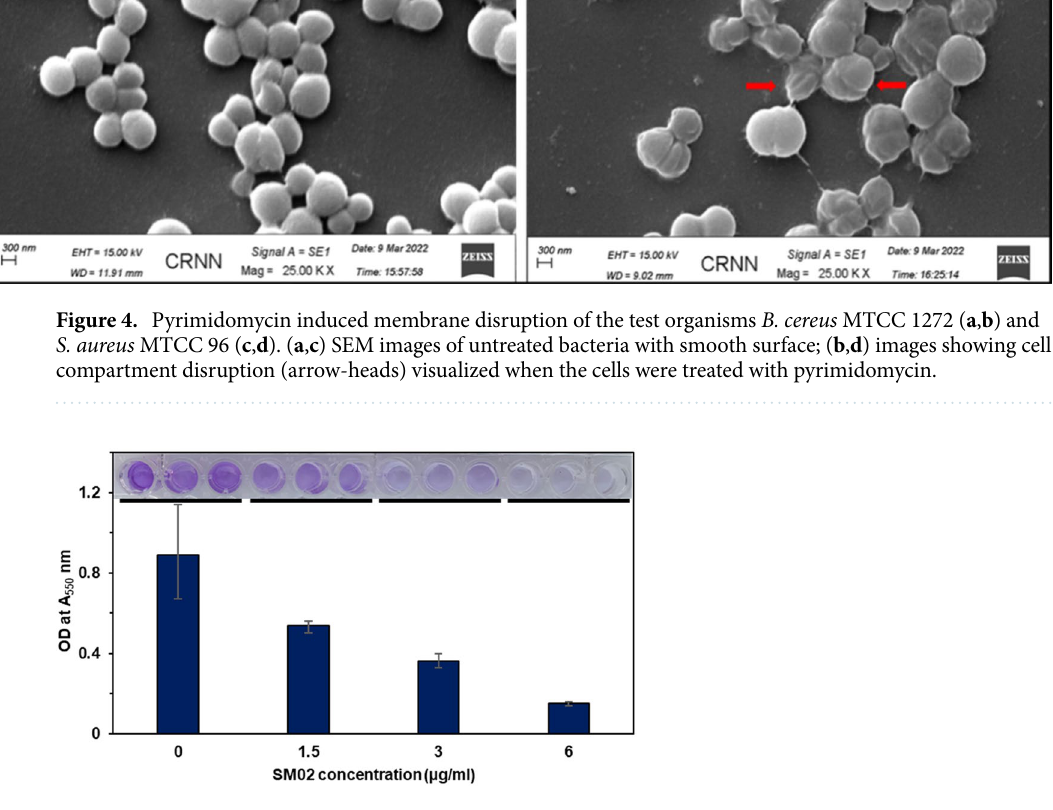
Figure 5. Antibiofilm properties of the compound pyrimidomycin. Increasing concentration leads to reduction of the biofilm